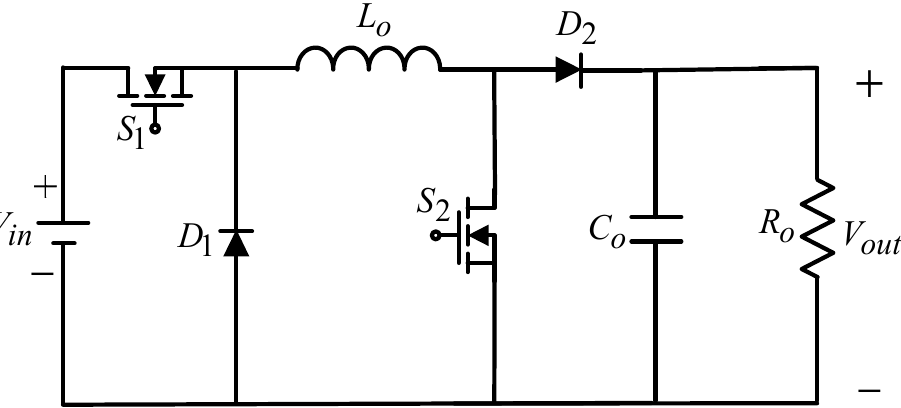
Figure 15. Circuit structure of a non-inverting buck-boost DC–DC converter.